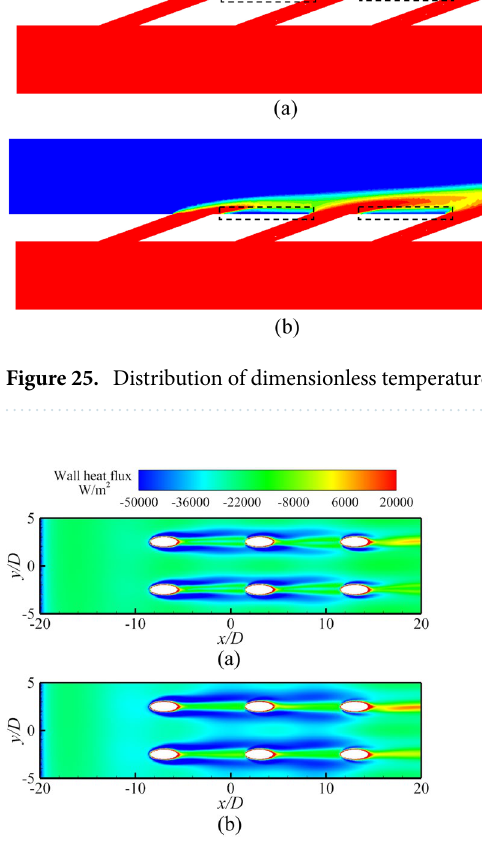
Figure 26. Contours of wall heat flux for Ref-case #1 with different Re g . ( a ) Re = 2900; ( b ) Re =